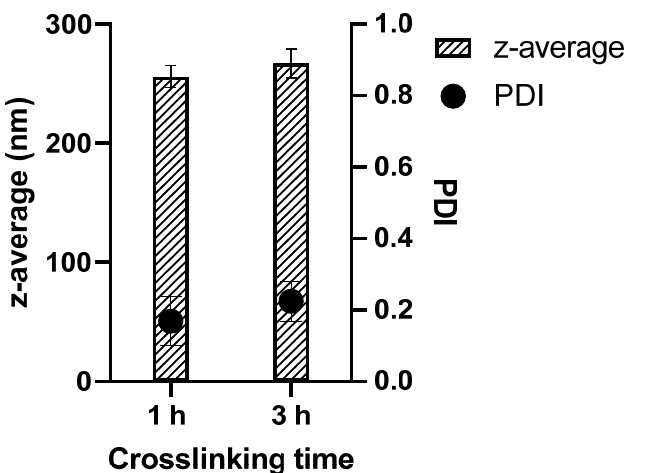
Figure 1. Particle sizes of soft (1 h crosslinking) and hard (3 h crosslinking) GNPs as well as the corresponding PDIs.